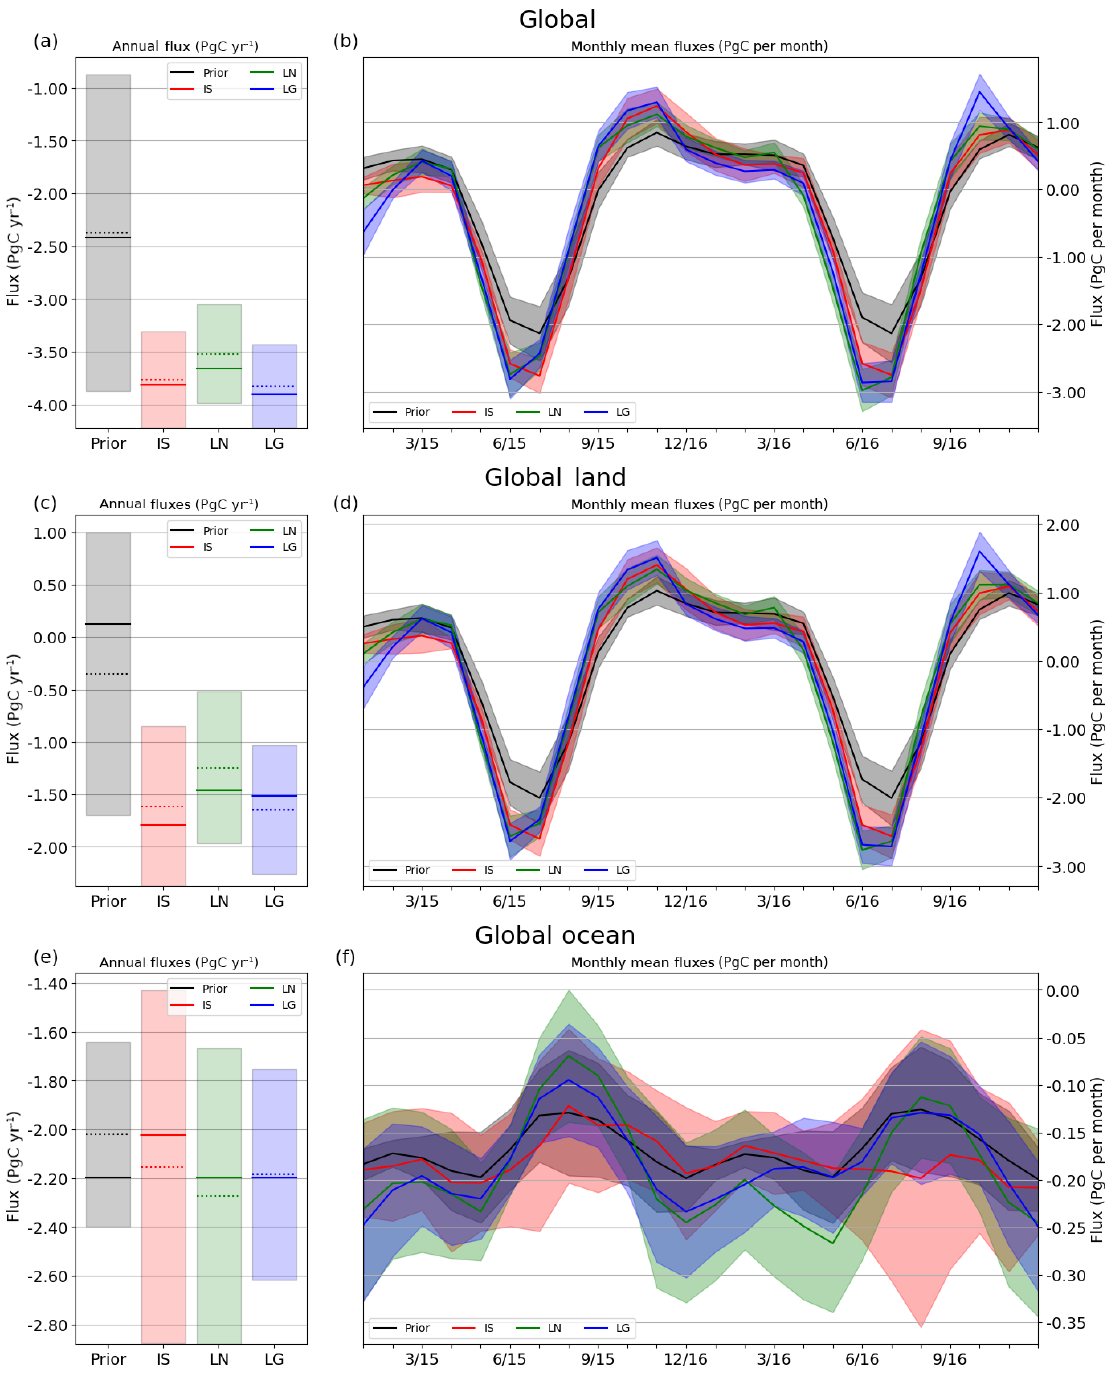
Figure 3. Prior (black) and posterior 2015–2016 mean (a, c, e) and monthly (b, d, f) fluxes constrained by in situ (red), OCO-2 land nadir (green), and OCO-2 land glint (blue) observations. (a, c, e) The shaded bar represents 1 standard deviation of the model ensemble about the ensemble mean annual mean flux (dashed line). The solid horizontal line for each bar depicts the median of the ensemble annual mean fluxes. (b, d, f) For each time series, the solid line represents the mean of the OCO-2 MIP ensemble, while the shading represents the ensemble standard